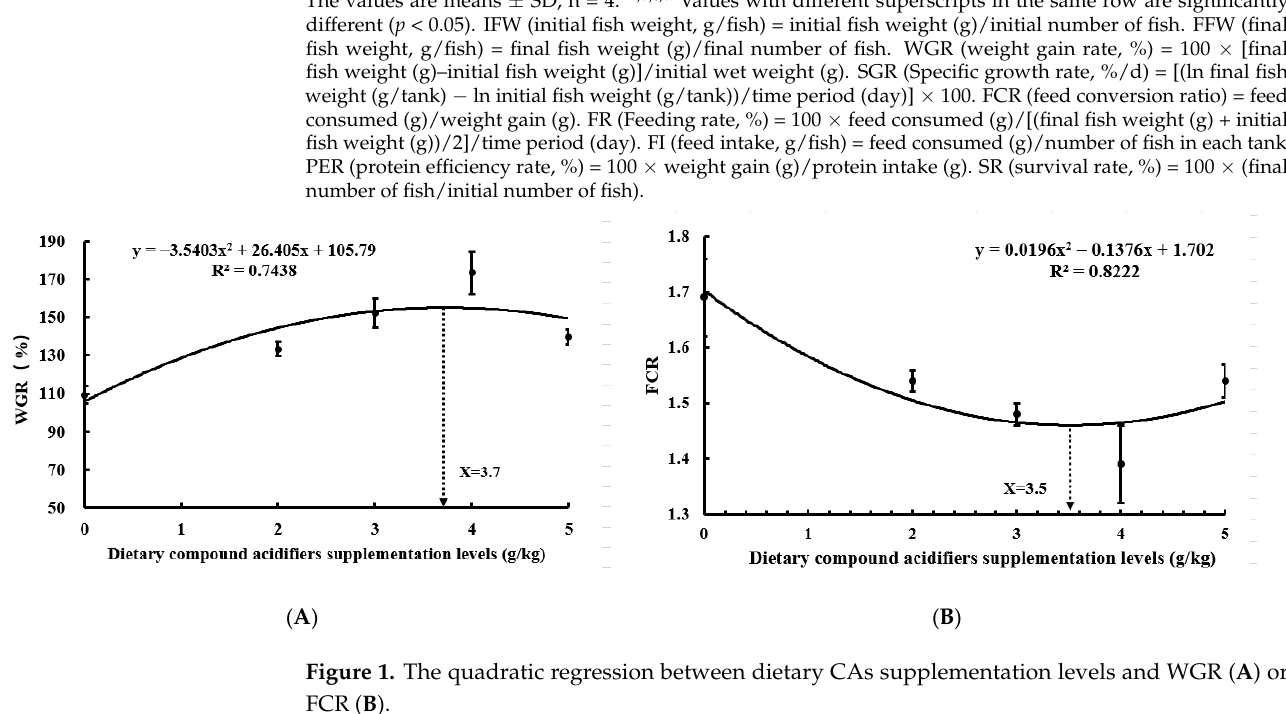
Table 2. Serum biochemical parameters of juvenile American eel in different CAs supplementation groups.